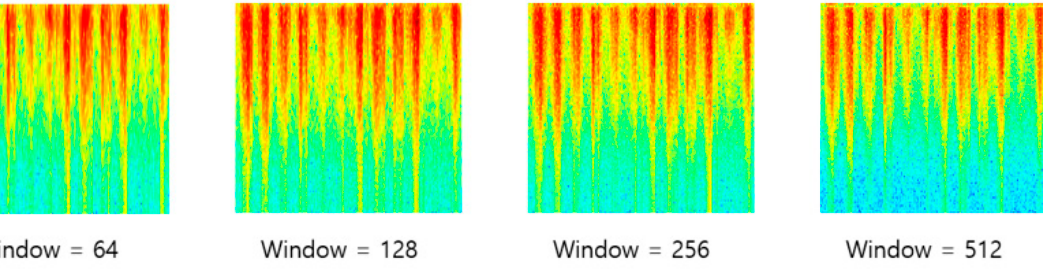
Figure 9. sEMG spectrograms based on changes in STFT window length.